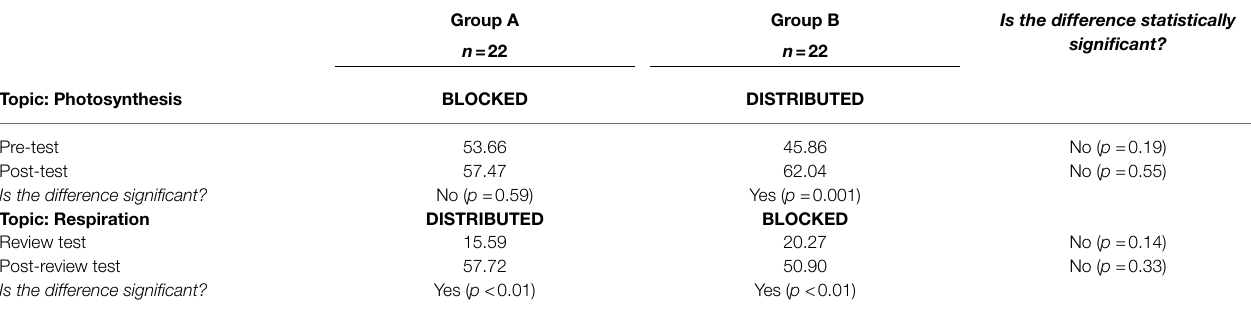
TABLE 3 | Comparing 9th grade chemistry classes using blocked practice vs distributed retrieval practice.